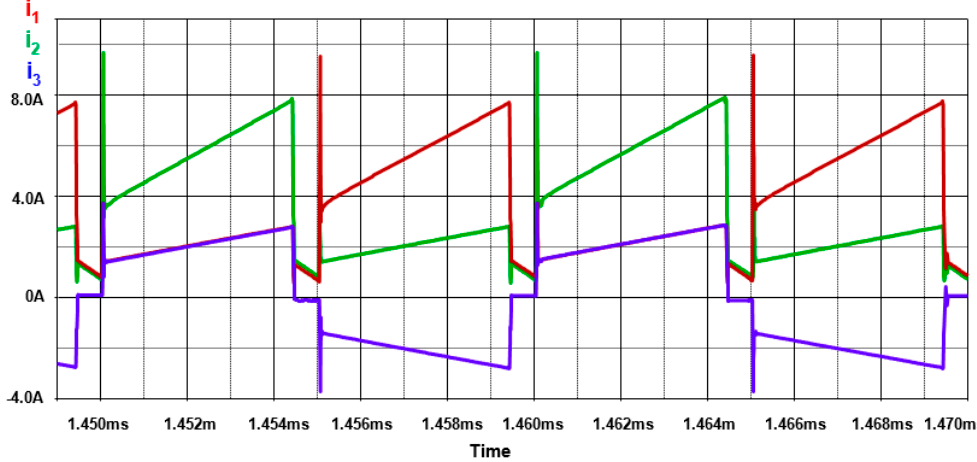
Figure 11. Current waveforms of the inductors L 1 – L 3 (100% of output power)—Simulation.